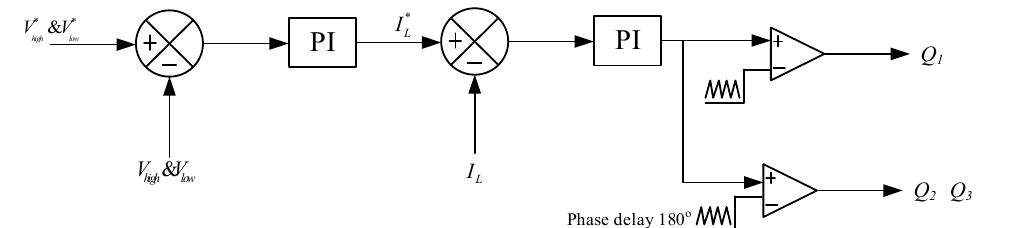
Figure 14. Experimental setup of proposed Converter I.